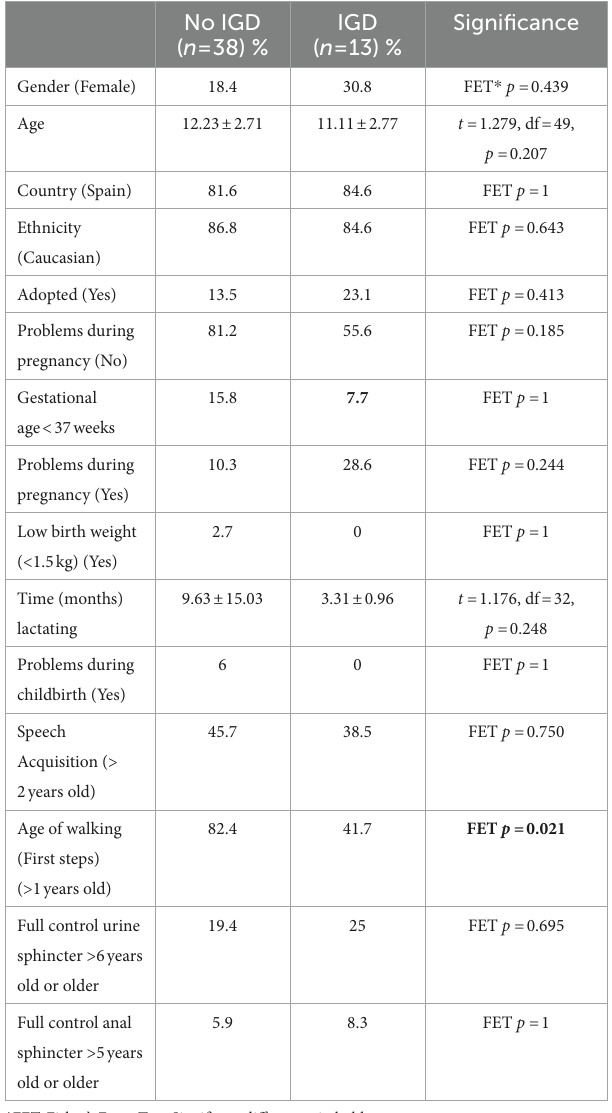
TABLE 1 Patient sociodemographic and developmental